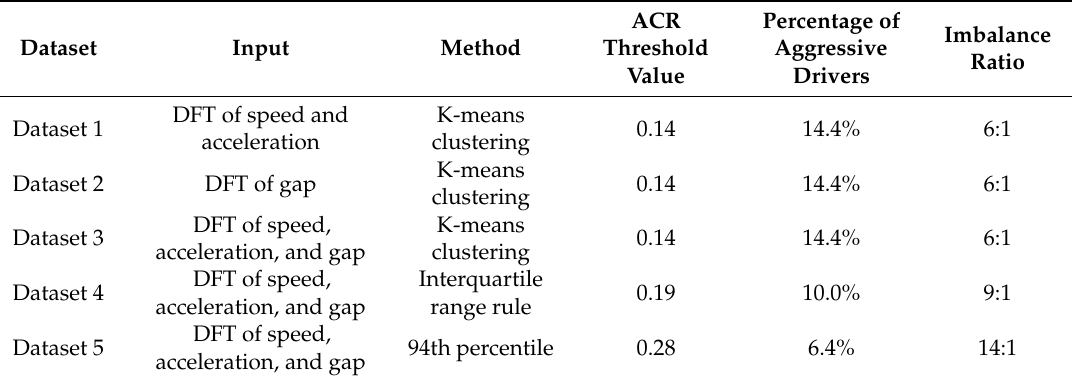
Table 2. Characteristics of